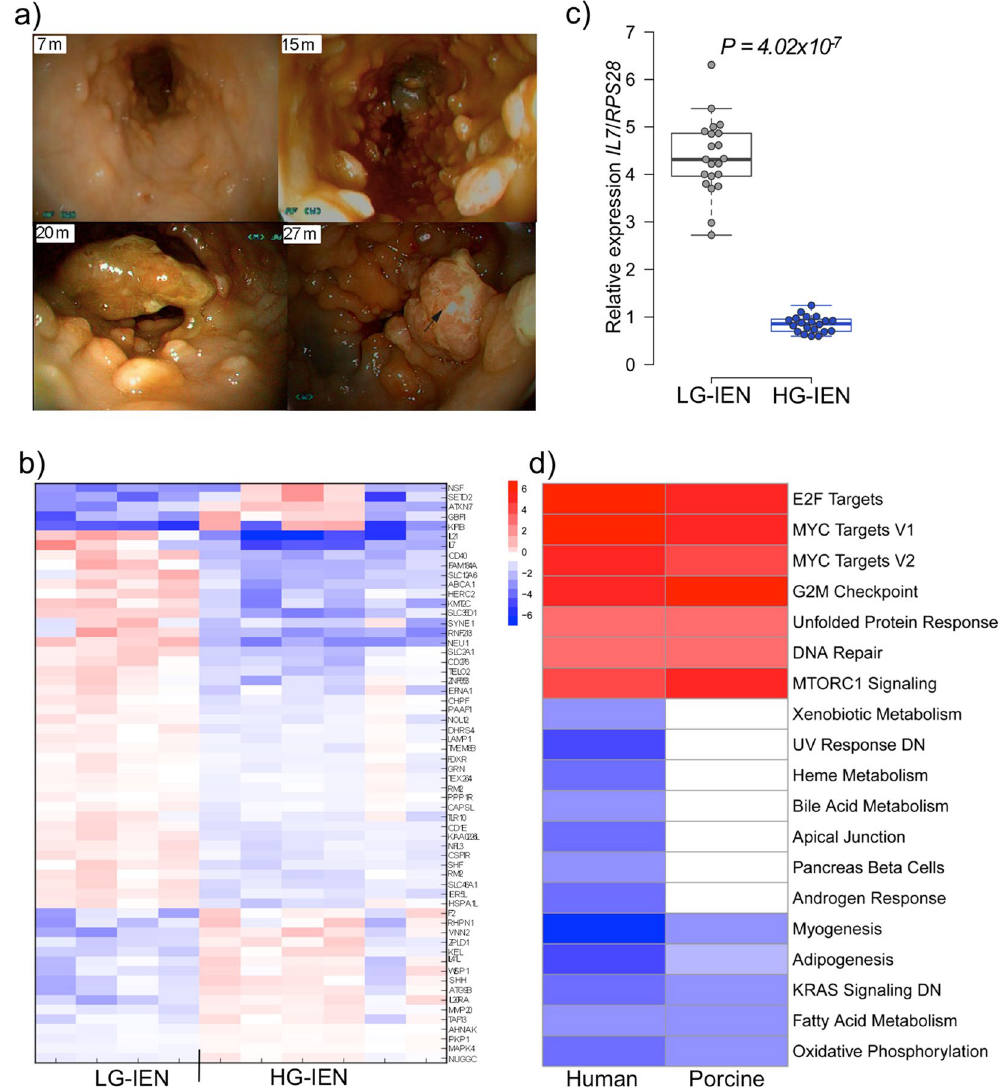
Figure 1. Polyposis and transcriptome patterns specific for low- (LG-IEN) and high-grade intraepithelial (HG-IEN) dysplasia in polyps of APC 1311/ + pigs. ( a ) Endoscopic images of an F1 APC 1311/ + animal (ID 73). Photographs were taken at approximately the same location (~15 cm depth) at ages 7, 15, 20 and 27 months as indicated. The tumour shown at 20 and 27 months was ~2.5 cm diameter, and at the later date had become hardened and more irregular. ( b ) Heatmap of the top 60 genes showing transcriptome pattern specific for LG- IEN and HG-IEN whole samples ranked by normalised expression differences between the two groups and P-value. ( c ) Illustrative quantitative PCR analysis of IL7 in LG-IEN and HG-IEN polyps (n = 20 per group, P = 4.02 × 10 − 7 ). qPCR measurements were normalised to porcine normal colonic mucosa samples (n = 6). ( d ) Gene set enrichment analysis for human microsatellite stable (MSS) T1 stage polyps versus human normal colonic mucosa from TCGA database and LG-IEN versus HG-IEN colon polyps in APC 1311/ +